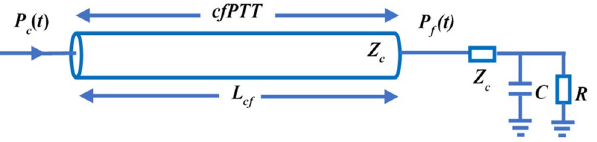
Figure 9. Simplified single tube-load model for estimating PTT from the carotid to femoral arteries. The tube represents the travel path between the carotid and femoral arteries. The cfPTT and vessel length L cf represent the time delay and travel distance between the carotid P c ( t ) and femoral P f ( t ) pressure waveforms,